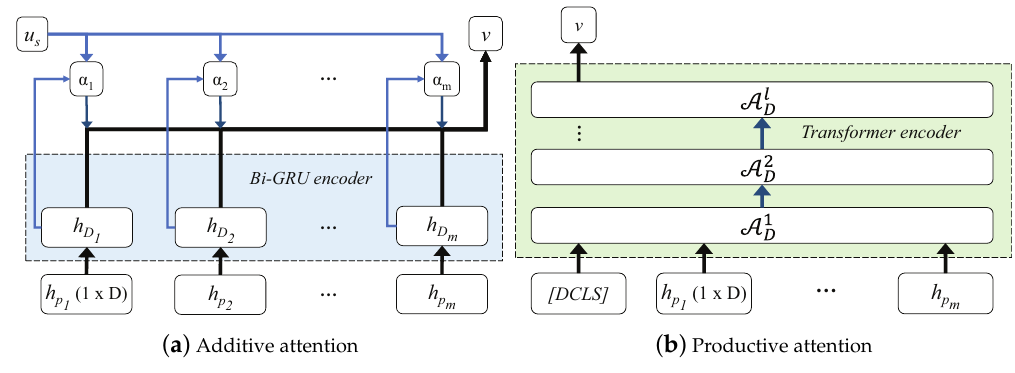
Figure 2. High-level structure of